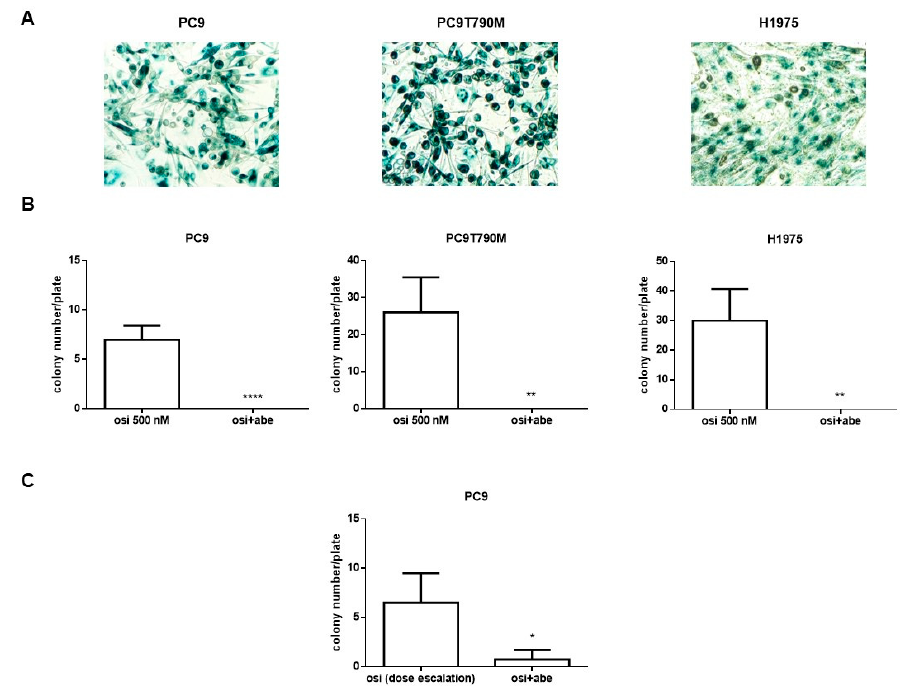
Figure 6. Effect of the combined treatment of abemaciclib and osimertinib on the acquisition of osimertinib resistance in osimertinib-sensitive cells. ( A ) PC9, PC9T790M, and H1975 cells were plated in 24-well plates and treated with 500 nM abemaciclib. After 2 weeks, senescent cells were quantified by SA ‐β‐ Gal staining (magnification 100×). ( B ) PC9, PC9T790M, and H1975 cells were plated in 24 ‐ well plates and treated with 500 nM osimertinib from the beginning in absence or in presence of 500 nM abemaciclib. Colony number was evaluated after 12 weeks for PC9 cells, 6 weeks for PC9T790M cells, and 4 weeks for H1975 cells. ( C ) PC9 cells were plated in 24 ‐ well plates and treated with increasing concentrations of osimertinib (starting from 25 nM to 500 nM) and after 12 weeks colony number was assessed (* p < 0.05, ** p < 0.01, **** p < 0.0001).